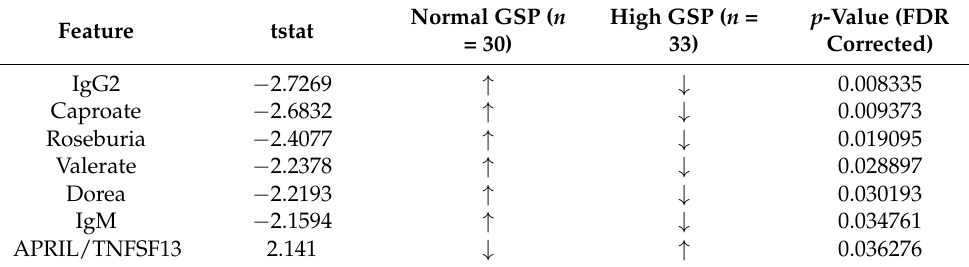
Table 4. Features which demonstrate differential responses between normal and high GSP lev- els. Normal GSP = 200–285; High GSP = 286–400; APRIL/TNFSF13 = A proliferation-inducing ligand/Tumor necrosis factor ligand superfamily member, 13; Two-tailed Student’s t- test. Arrows ( ↑ / ↓ ) represent features that were increased/decreased in the corresponding population. An FDR corrected p -value is shown in the last column.